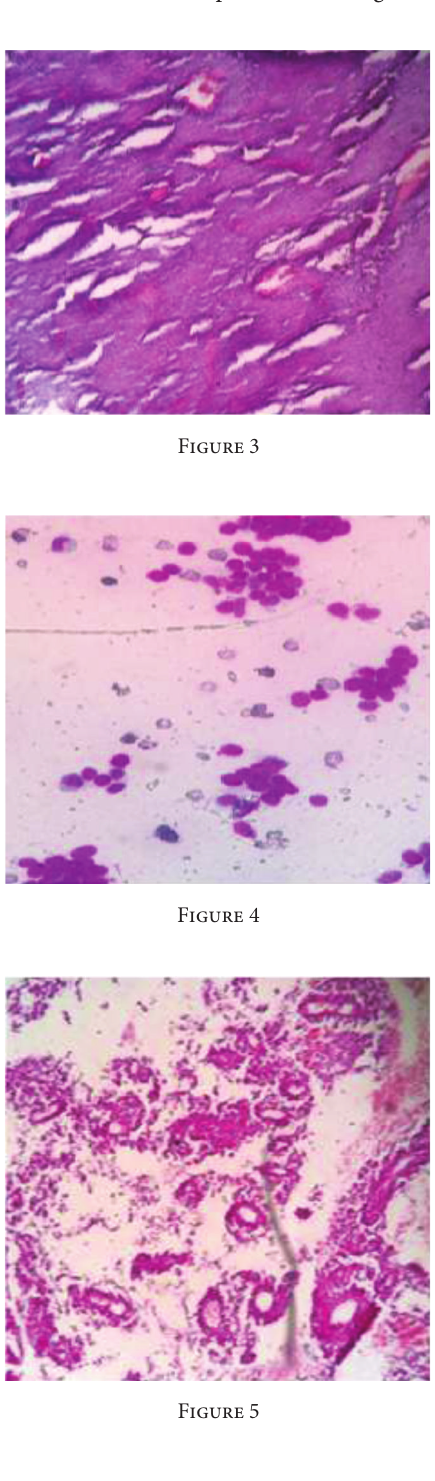
a peak incidence at 10–15 years. The male-to-female ratio is 3 : 2. Although it can involve any bone, it is more